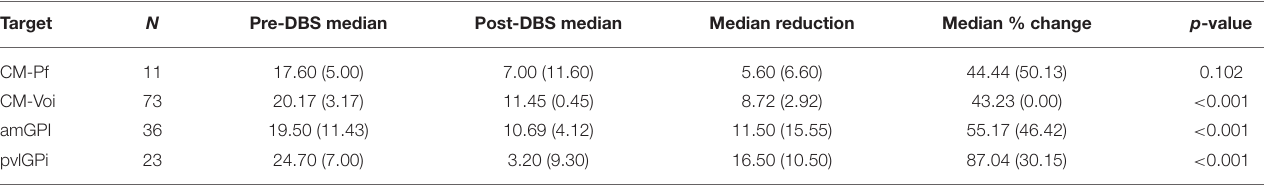
TABLE 3 | Overview of YBOCS outcomes for the different targets after DBS surgery at maximum follow-up. Target